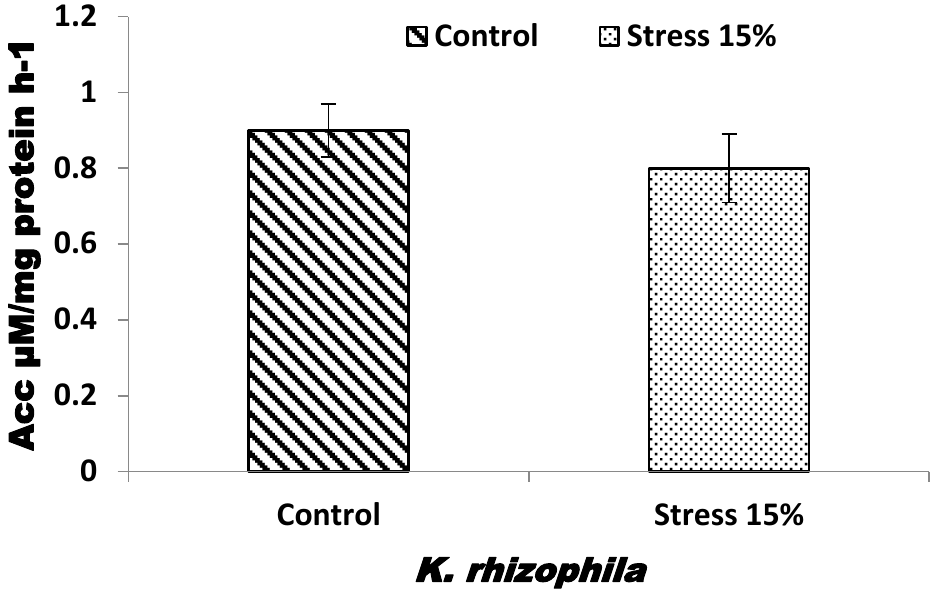
Figure 1. ACC deaminase activity of K. rhizophila 14asp under control and 15% NaCl stress conditions. The difference above each column is described at p value < 0.05 and the bars show error of the mean where n = 3.